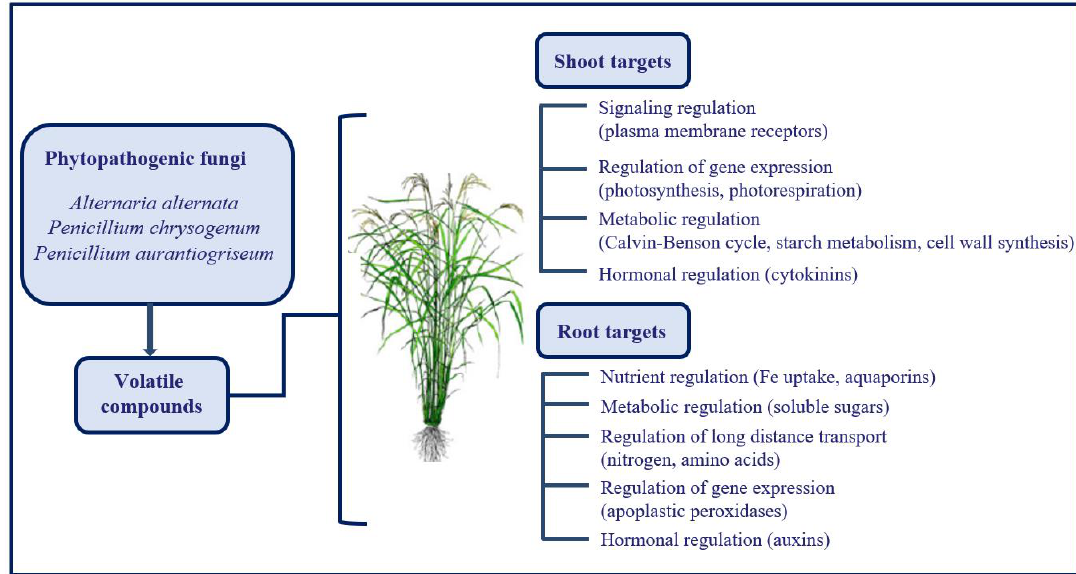
Figure 2. Schematic representation of key mechanisms targeted by volatiles of phytopathogenic fungi in normal and drought conditions. The scheme is based on observations reported by Sánchez-López et al. [106] and García-Gómez et al. [26,108]. The complex regulatory network initiated by these volatile compounds, which are emitted by phytopathogenic fungi, comprises regulation at the levels of gene expression, metabolites, nutrient allocation, and hormones, which together balance plant development and circumvent the possible growth loss caused by adverse environmental conditions.